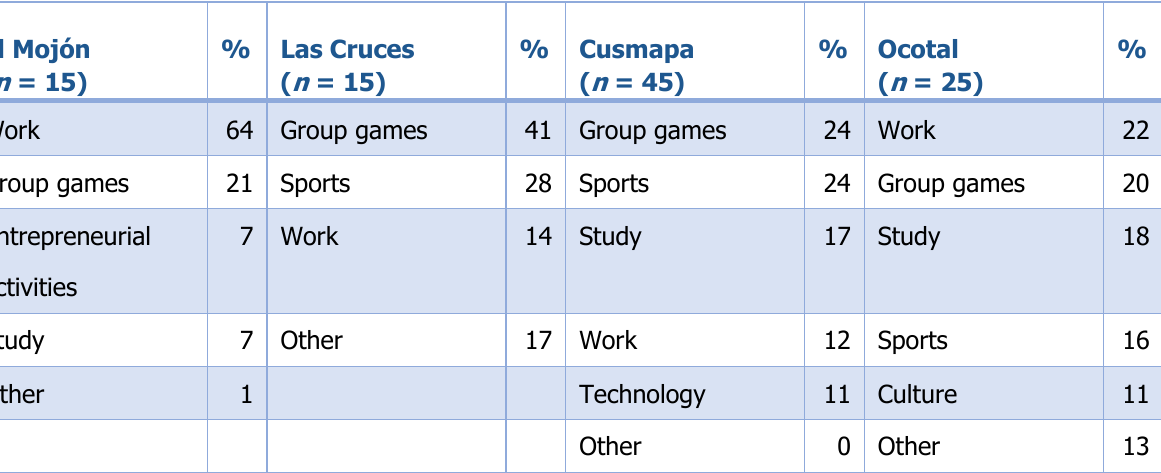
Table 4. Percentage of Responses by Each Community for the Statement: “My hobbies